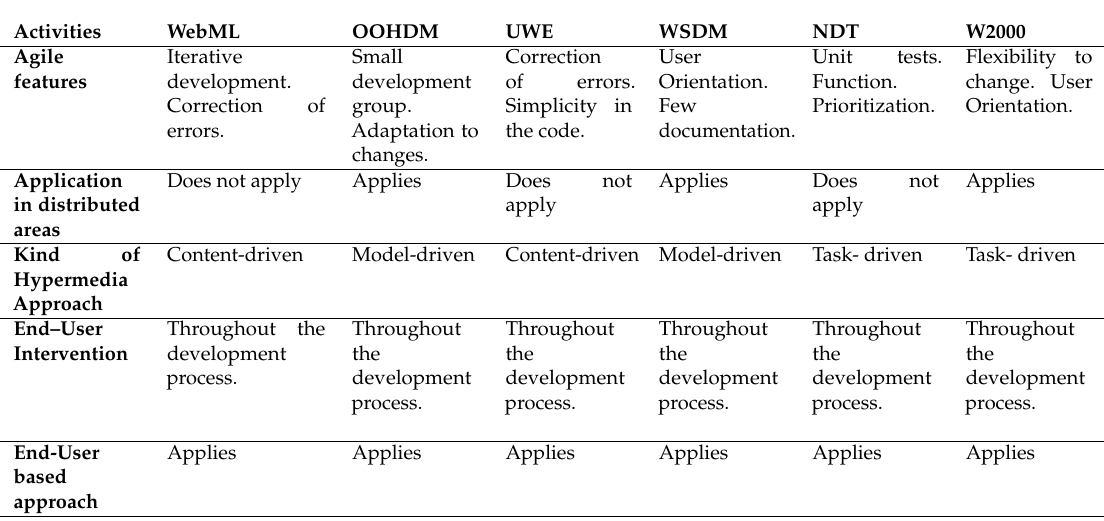
Table 10. Comparison of the methodologies within the perspective of agile development